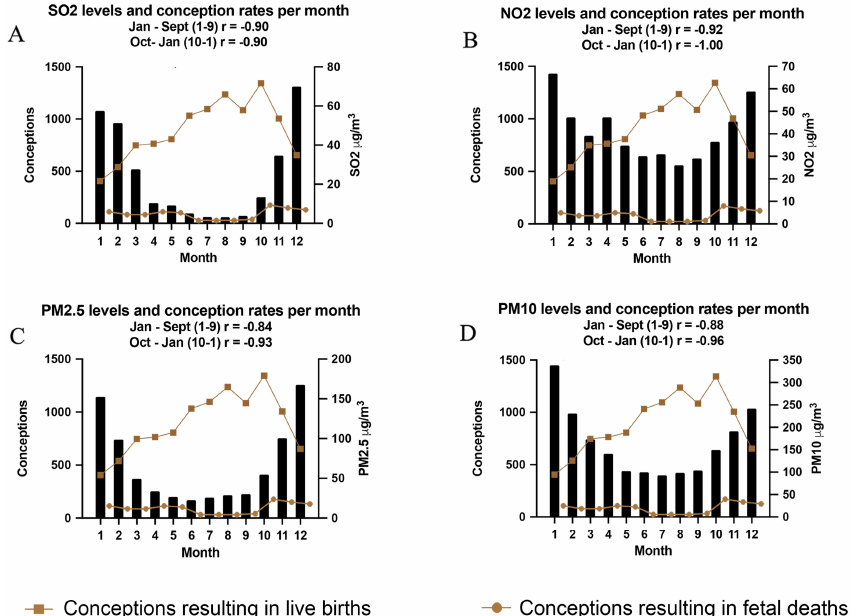
Figure 3. Monthly average levels of daily air pollutants SO 2 , NO 2 , PM 2.5 and PM 10 ( A – D , respectively) and successful conceptions per month at UMH from April 2013–March 2015. Correlations between each pollutant level SO 2 , NO 2 , PM 2.5 and PM 10 and successful conceptions were calculated from January to September, and from October to January. Monthly conception rates that resulted in early (<20 weeks) fetal death (brown line with circles) are shown. This data is from our previous study by Enkhmaa et al. [13]. These data points have been multiplied by 10 for clarity.